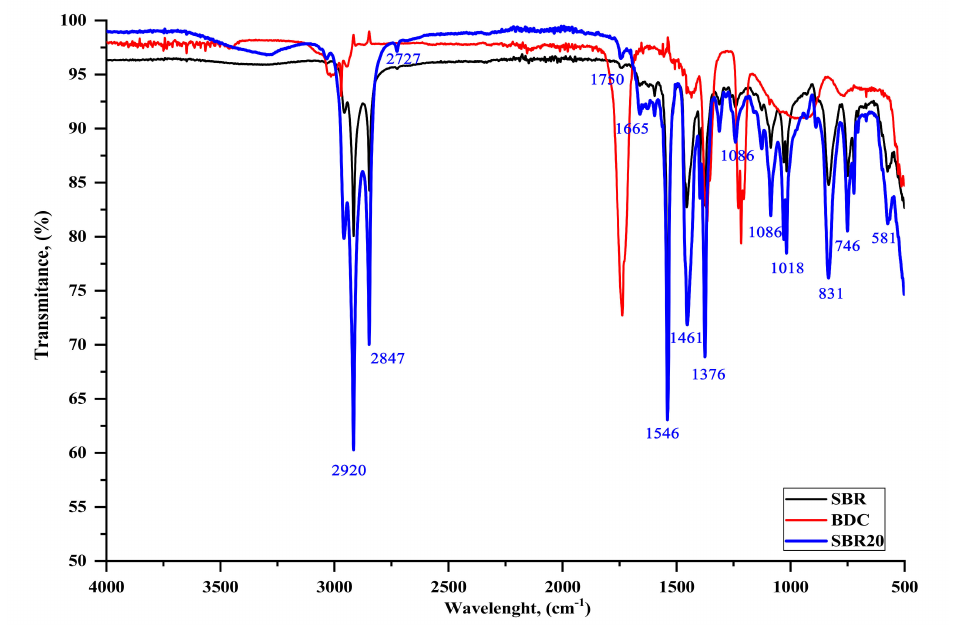
Figure 5. Fourier transform infrared spectroscopy (FTIR) spectrum of samples containing 0 and 20 phr BDC in SBR composites relative to the BDC spectrum.